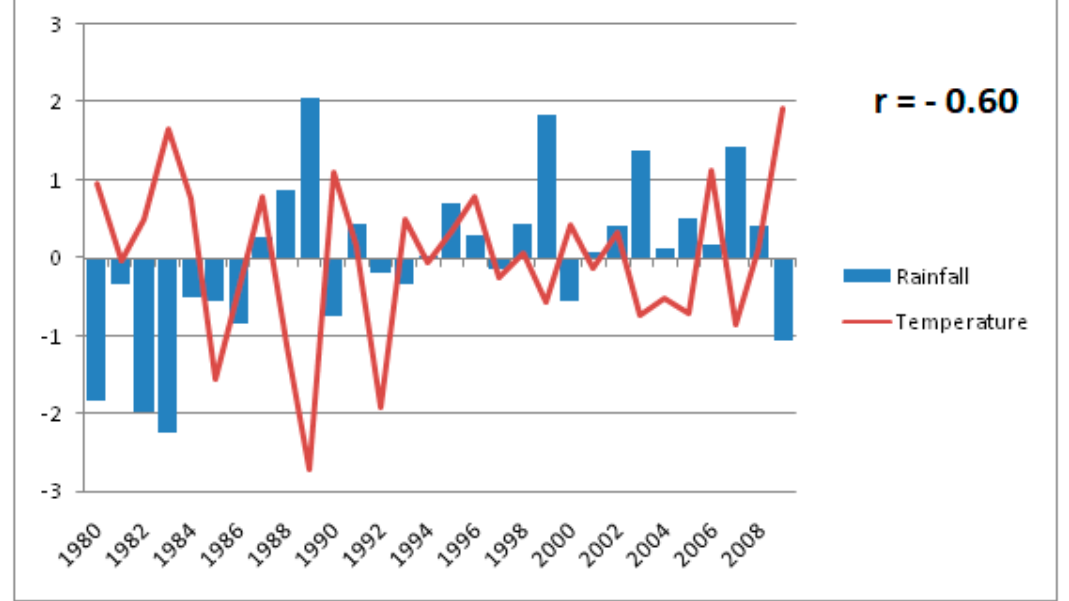
Figure 3. Interannual variability of June to September (JJAS) rainfall and surface temperature normalized anomalies from 1980 to 2009 for the RegCM4 model over West Africa (20°W–20°E; 5°N–17.5°N).